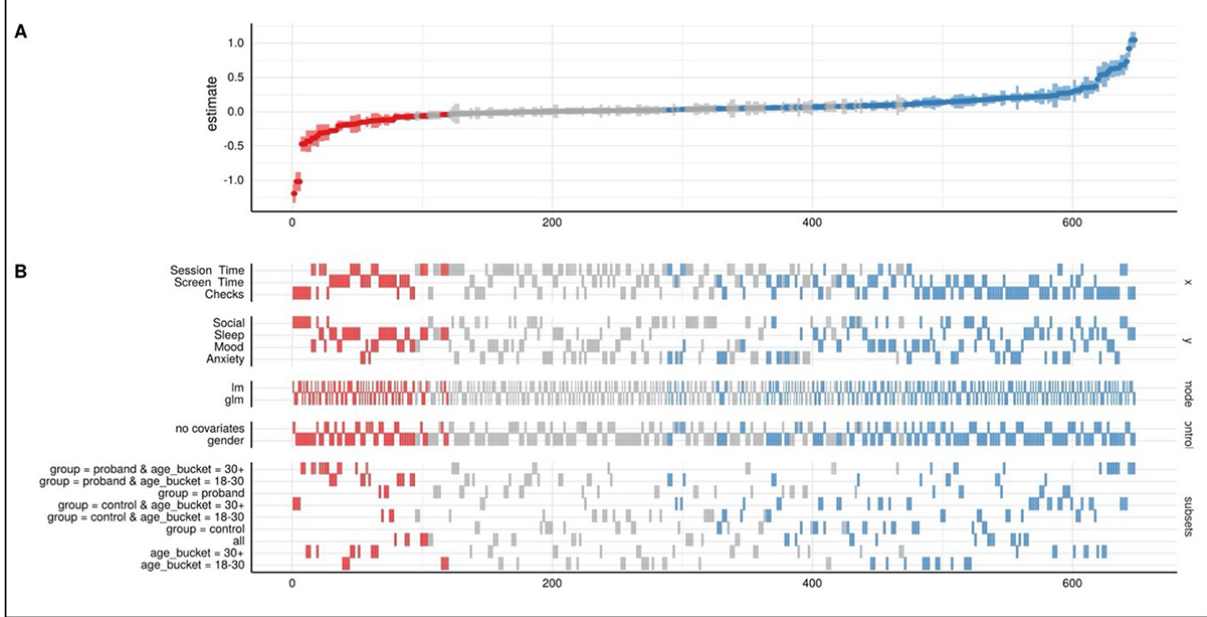
Figure 1. Specification curve analysis of screen time and symptoms, as a visual representation of the >600 combinations of regression analyses between screen time metrics and self-reported mood, anxiety, sleep, and sociability: (A) regression coefficient, (B)